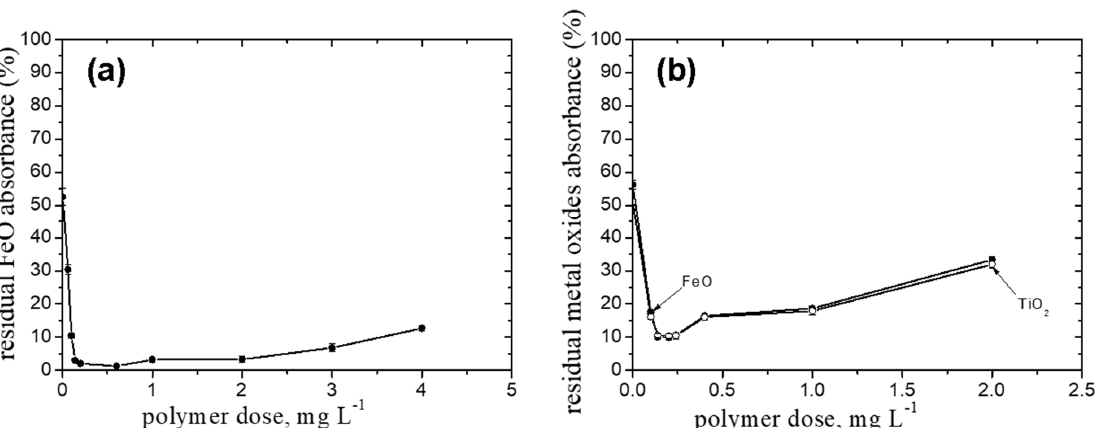
Figure 8. The residual metal oxides absorbance dependence (%) on the polymer dose ( TMAP 0.7 –P )— suspension prepared with a mixture of FeO, NaCl, Na 2 SO 4 , NaNO 3 , CaCl 2 , MgCl 2 ( c s = 1 × 10 − 3 M) and kaolin (0.2 g L − 1 ); c ip = 1 g L − 1 ; c FeO = 0.2 g L − 1 ; settling time: 30 min ( a ) and a mixture of metal oxides ( c Feo = 0.05 g L − 1 , c TiO2 = 0.05 g L − 1 ), c ip = 1 g L − 1 ; settling time: 120 min ( b